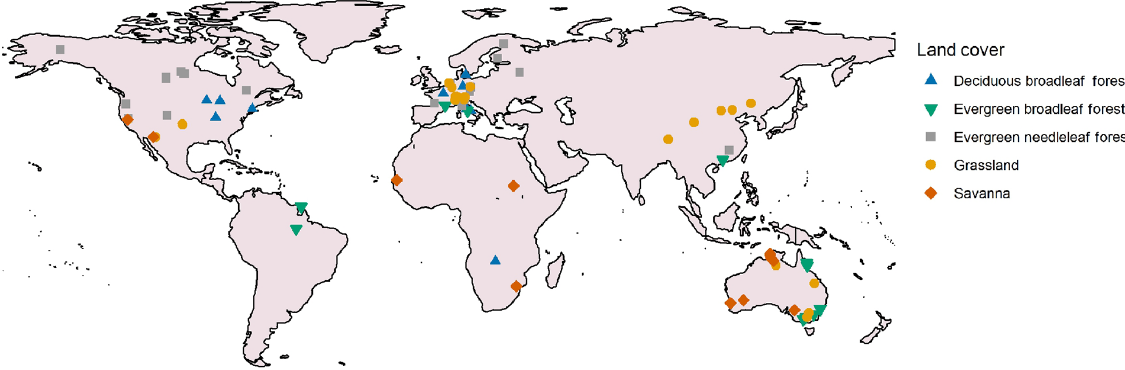
Figure 2. Location and vegetation type of the 93 included flux tower